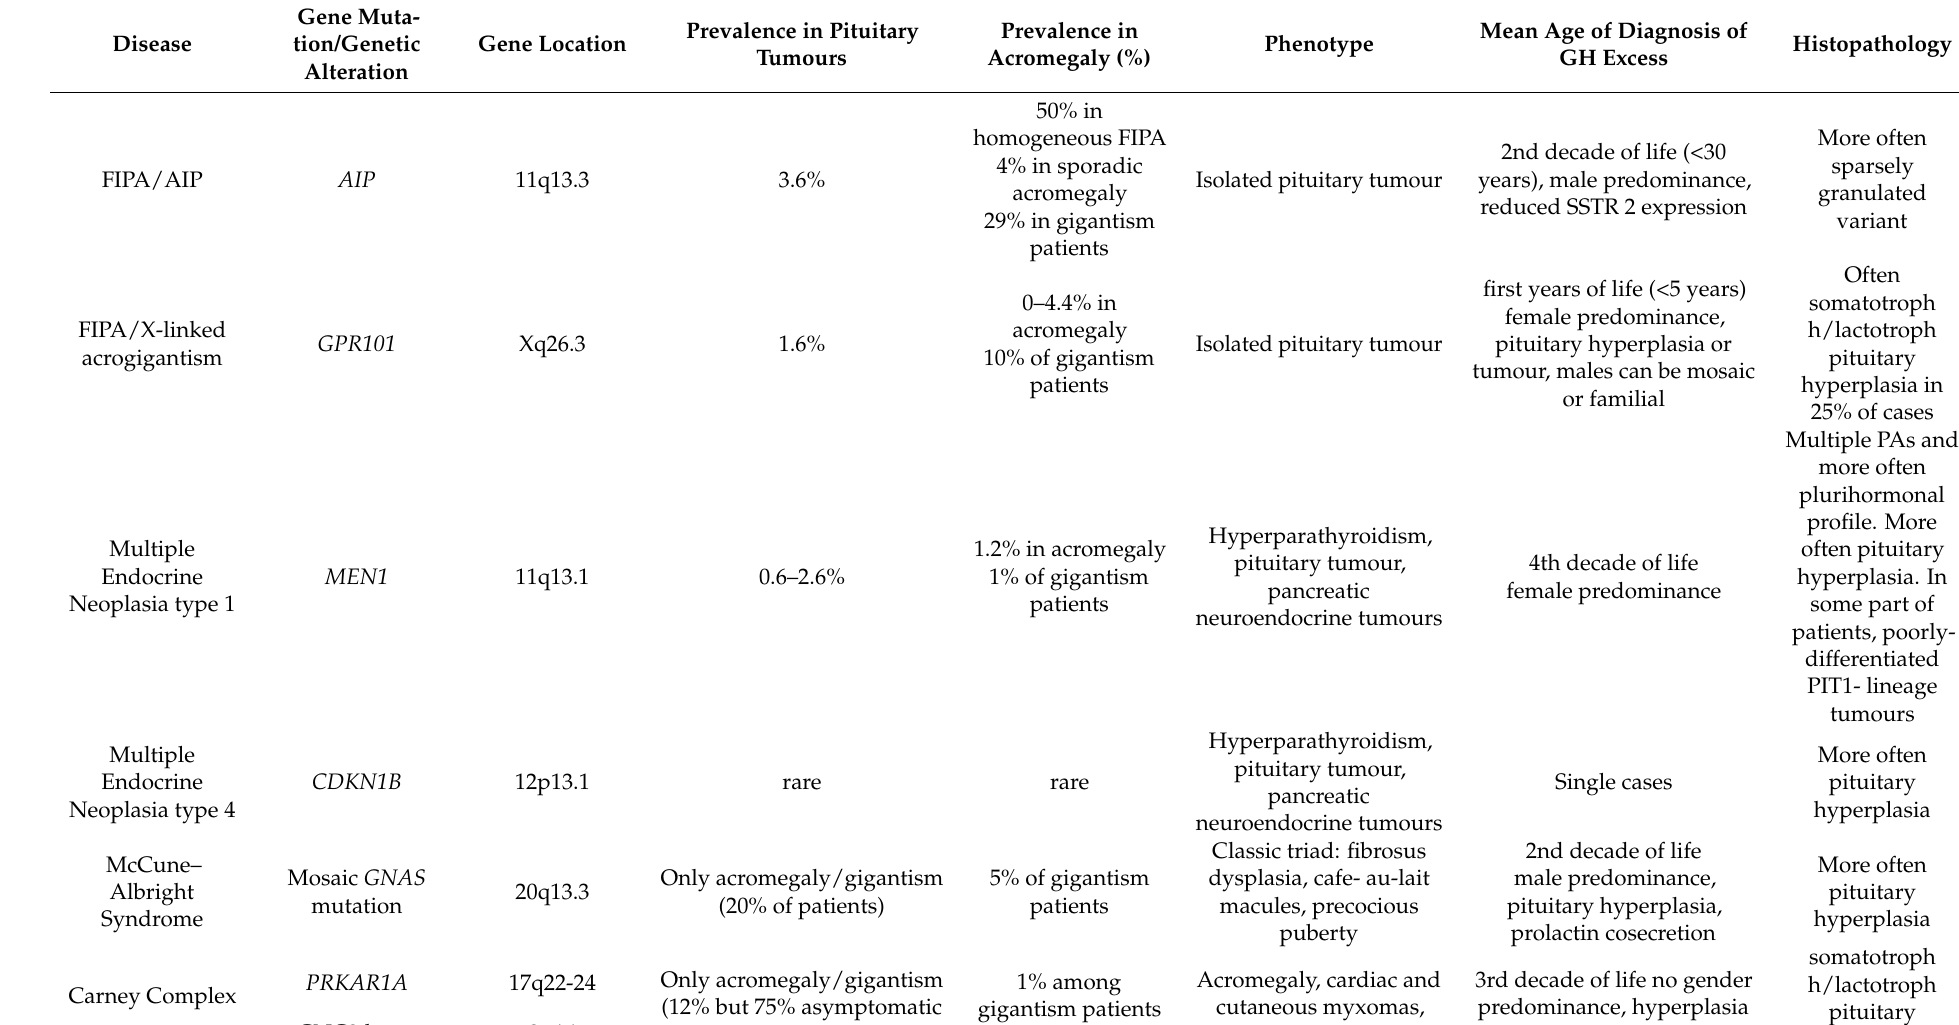
Table 1. Germline and somatic GNAS mutations associated with acromegaly and gigantism (adapted from Gadelha et al.